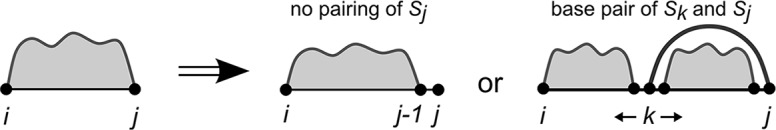
Secondary structure decomposition by Waterman and Smith (1978).The figure illustrates for a given subsequence Si..j a unique nested secondary structure decomposition based on the distinction of all possible pairing states of the last nucleotide Sj. Note, this scheme applies to all RNA structure-related algorithms presented here.